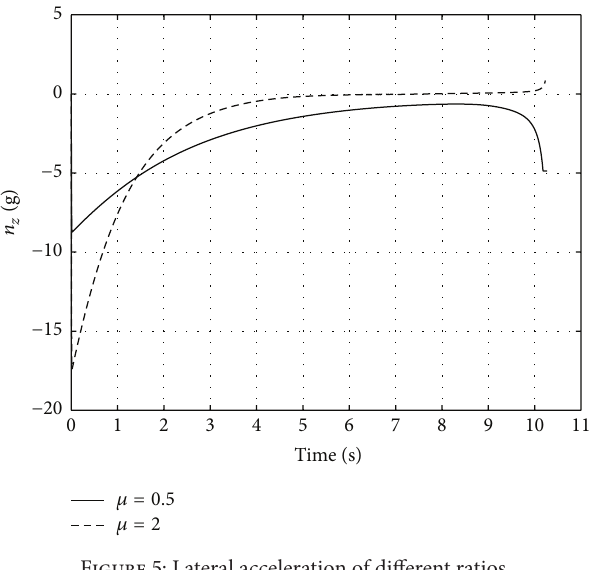
Figure 5: Lateral acceleration of different ratios.